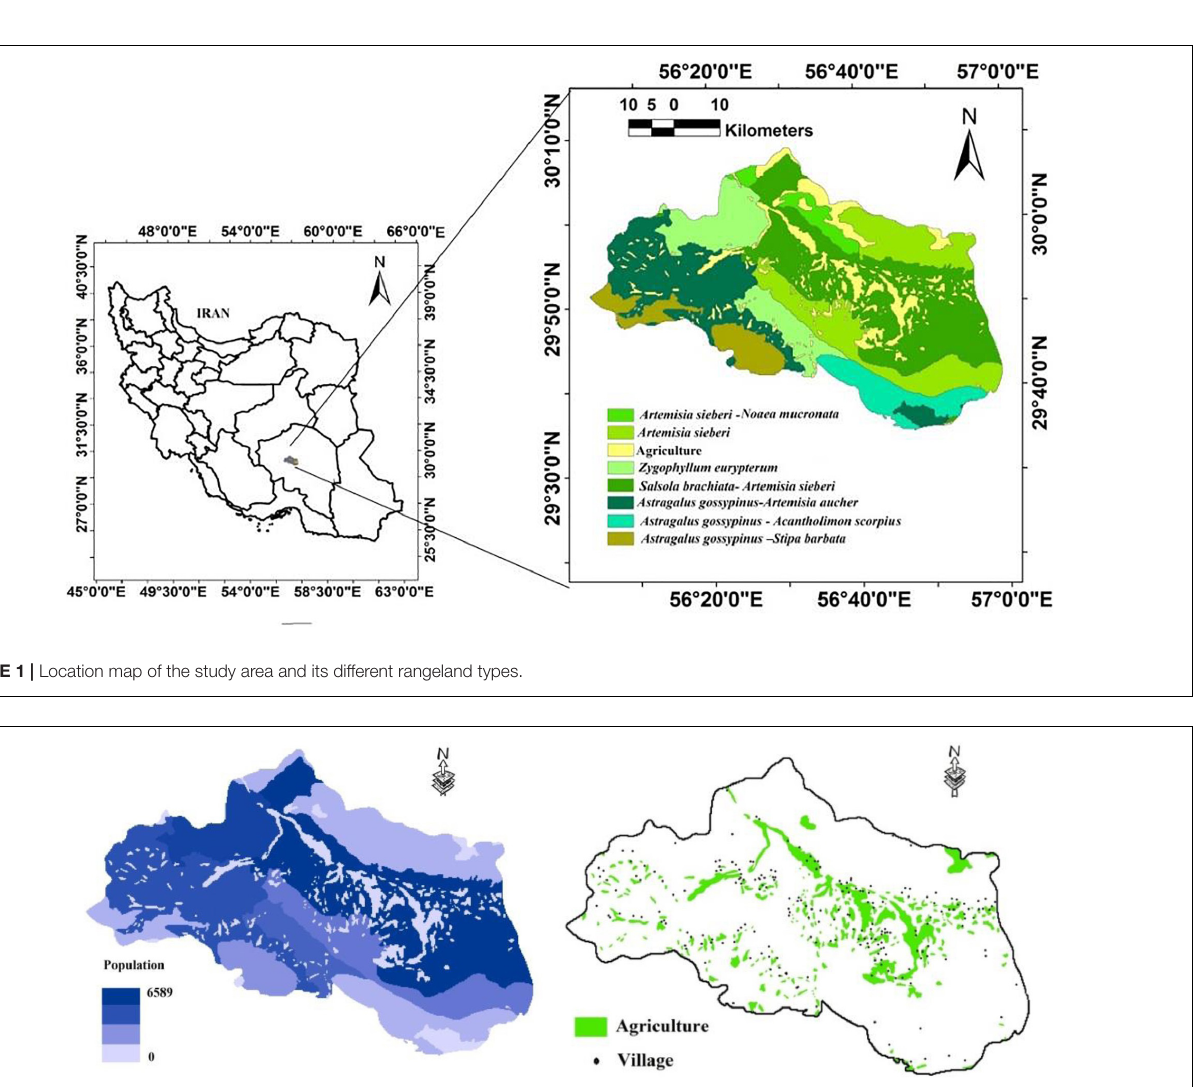
FIGURE 2 | Distribution of population, villages, and agricultural lands across the basin.